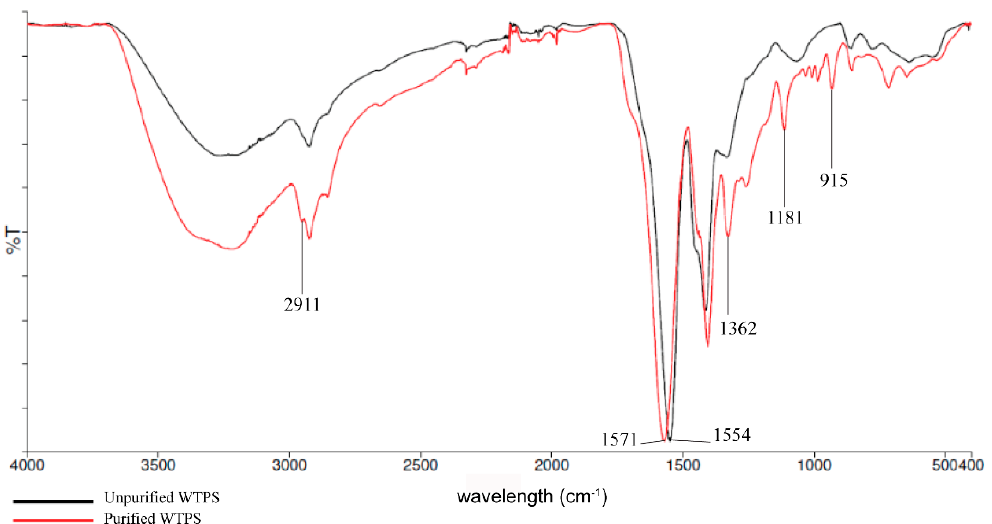
Figure 2. Fourier ‐ transform infrared (FTIR) transmission spectra (%T) at the wavelength (cm − 1 ) of unpurified and purified WTPS.